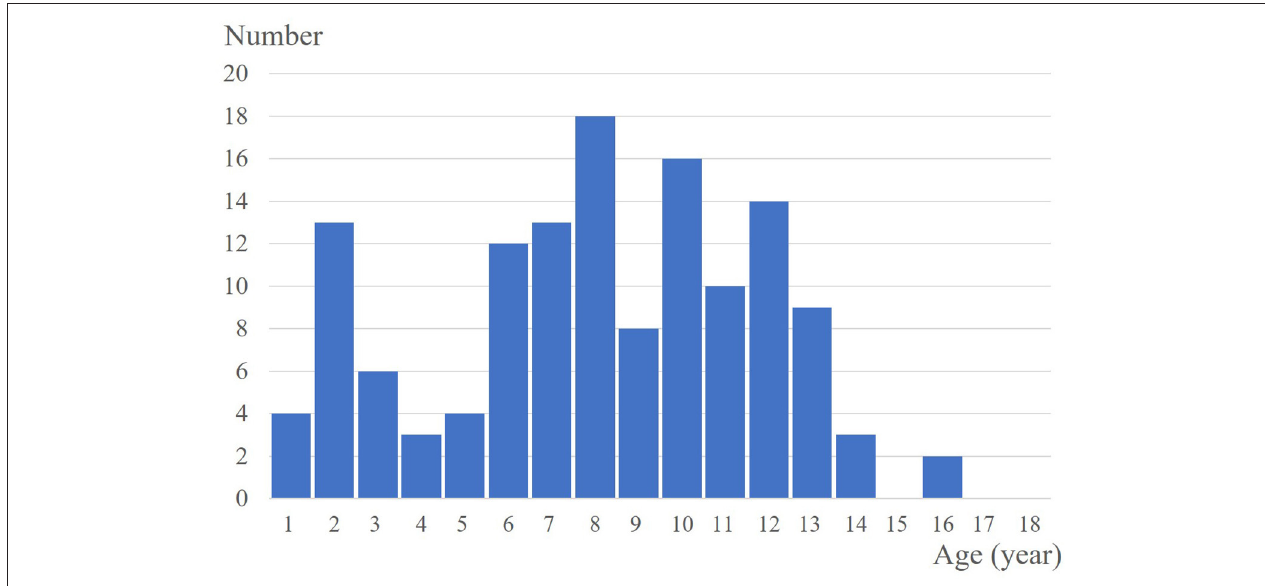
FIGURE 1 | Population distribution with age in pediatric PM.